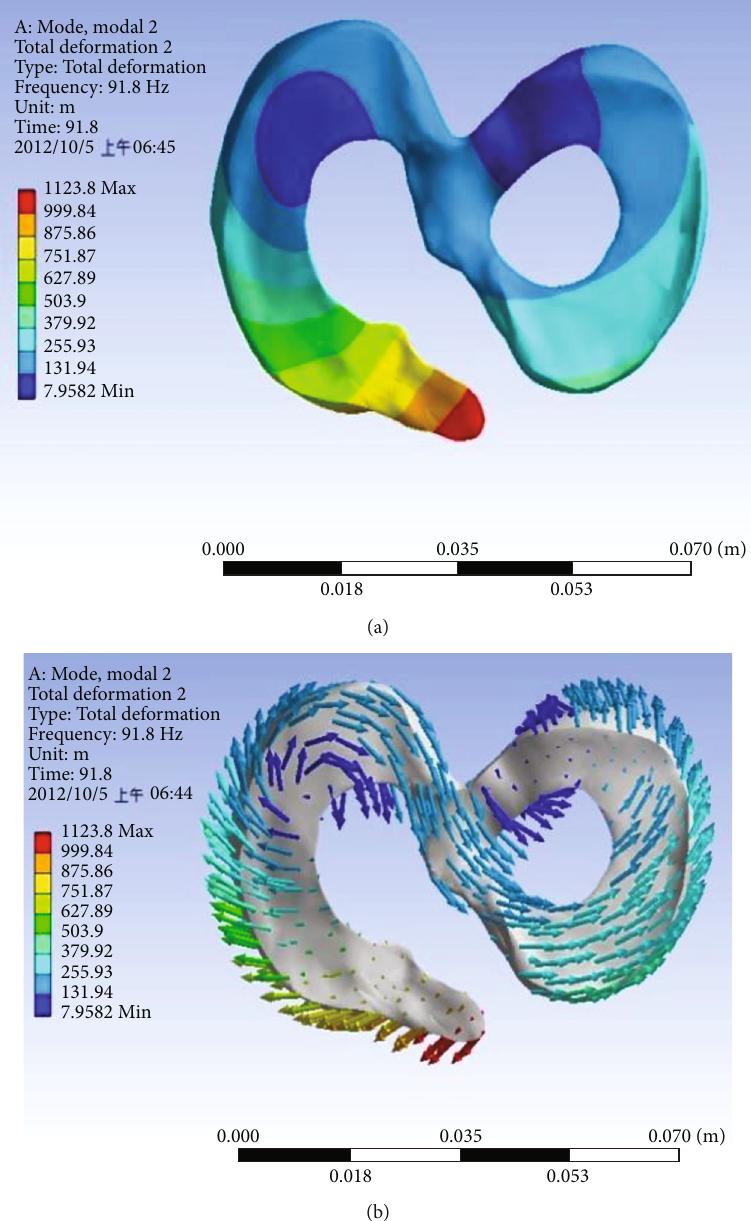
Figure 6: Second mode shape of meniscus model at 91.8 Hz (shrinkage – expansion vibration in the surface perpendicular to thickness direction). (a) Second mode shape. (b) Vector plot of second mode